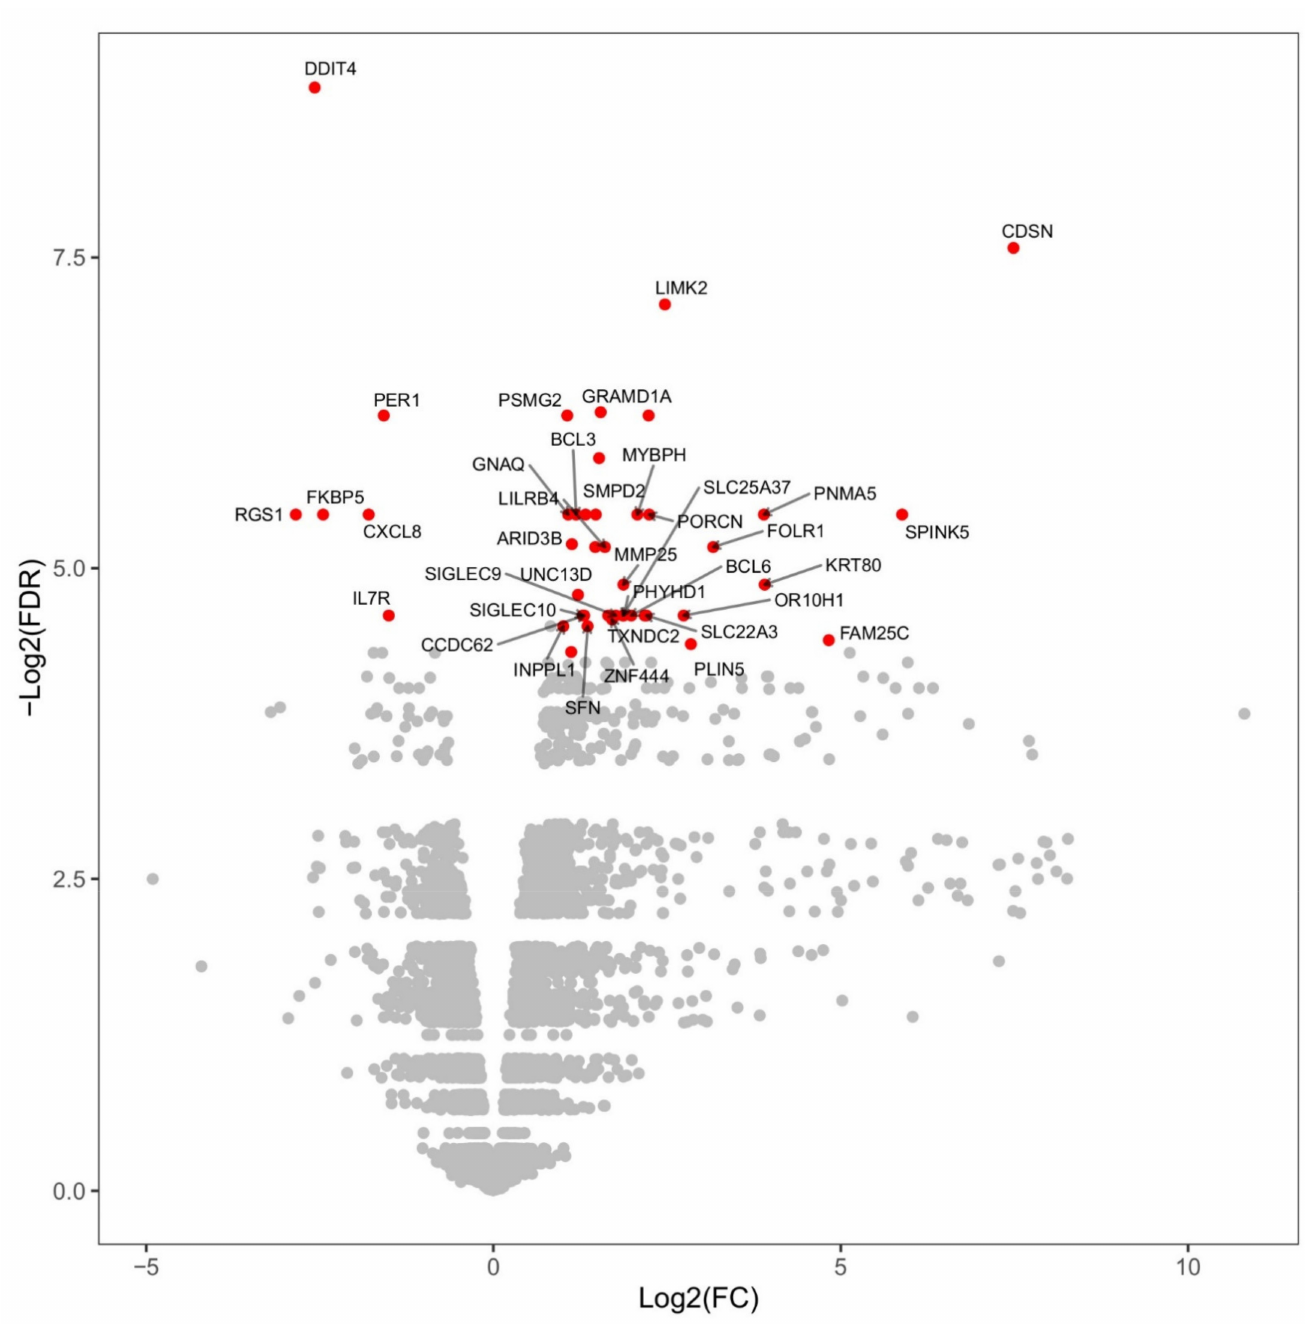
Figure 2. Volcano plot for gene regulation at 6 h post-vaccination . Changes measured at 6 h post-vaccination as compared to time 0 h (i.e., pre-vaccination). On the x-axis, the base-2 logarithm of the fold-change; on the y axis, the negative base-2 logarithm of the false discovery rate (FDR) for the fold-change. The dots in red are those that exhibit statistically significant differential regulation at 6 h, defined as abs (log2(fold change)) ≥ 1 and FDR ≤ 0.05. The long versions of the gene annotations corresponding to the short gene names appearing in the plot can be found in Table